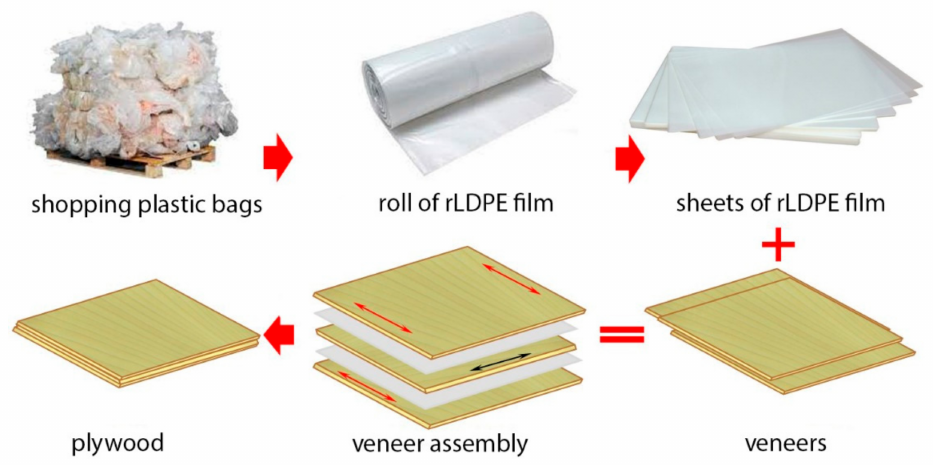
Figure 1. Schematic of plywood samples